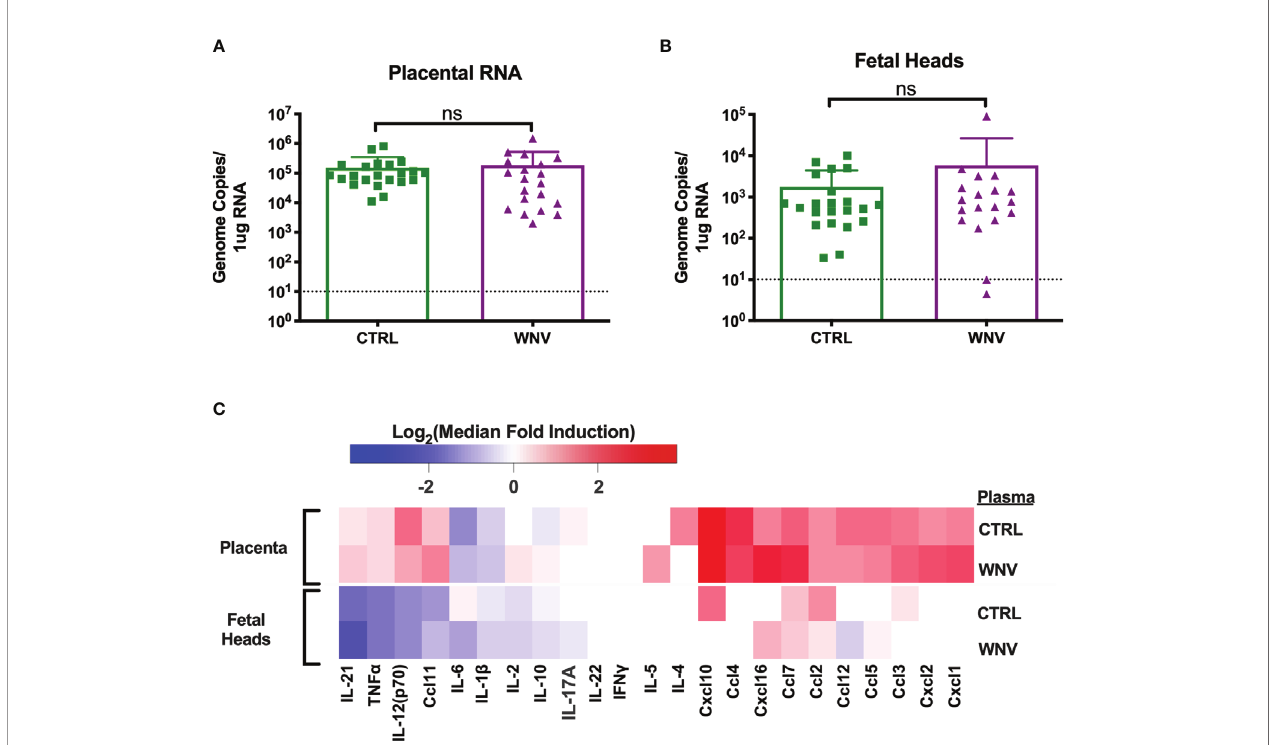
FIGURE 4 | Molecular characterization of ZIKV infection in the fetus and placenta. RNA was extracted from (A) placentas (CTRL n=22; WNV n=20) and (B) fetal heads (CTRL n=22; WNV= 19) to examine viral loads by qRT-PCR. Signi fi cance was determined by Mann-Whitney U-test, and the dashed lines represent the limit of detection. Overlaid bar plots depict mean and SD. (C) Tissue homogenates from placentas and fetal heads were evaluated for in fl ammatory markers by multiplex ELISA. Data are shown as a log 2 transformed median fold induction over the median pg/ml expression in the uninfected condition. ns, not signi fi